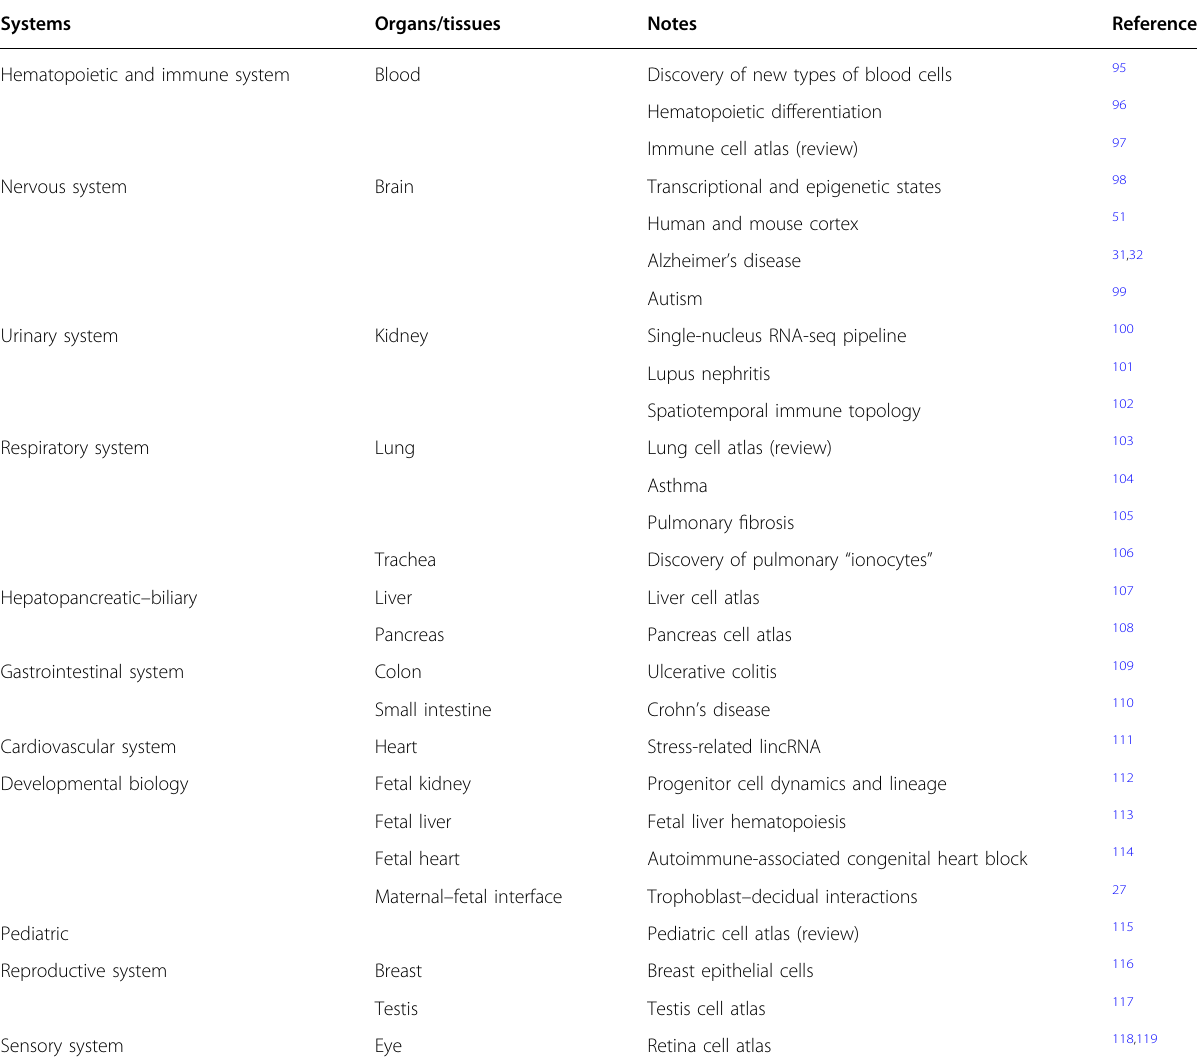
Table 1 Single-cell pro fi ling of major human organs and